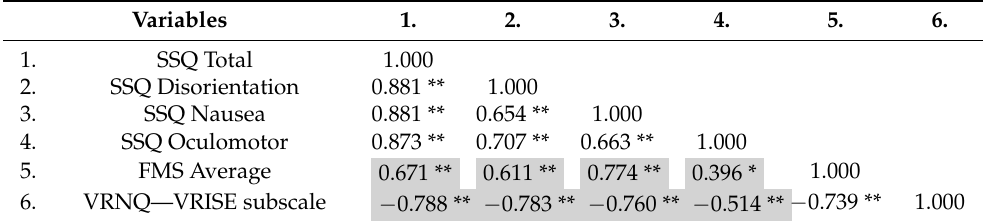
Table 5. Correlation matrix for LA_RFG condition—Spearman ( ρ ) correlation coefficients for com- bined VRISE measures ( n =